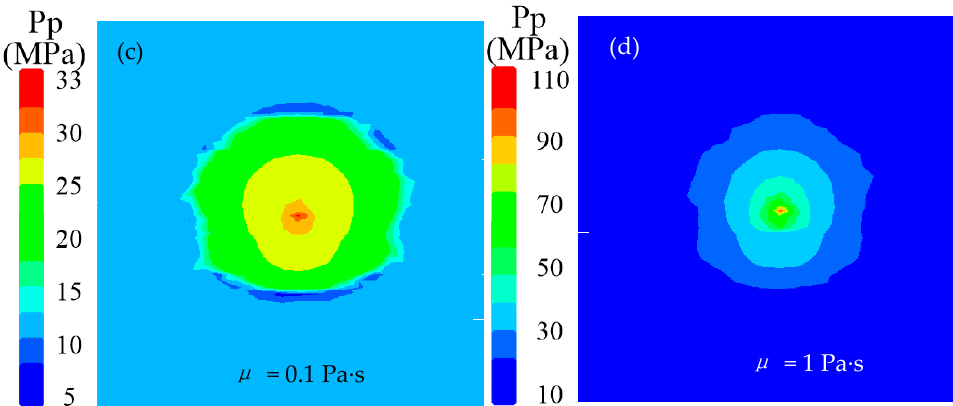
Figure 10. Fluid pressure distributions in different cases, with the fluid viscosity of ( a ) μ = 0.001 Pa·s,